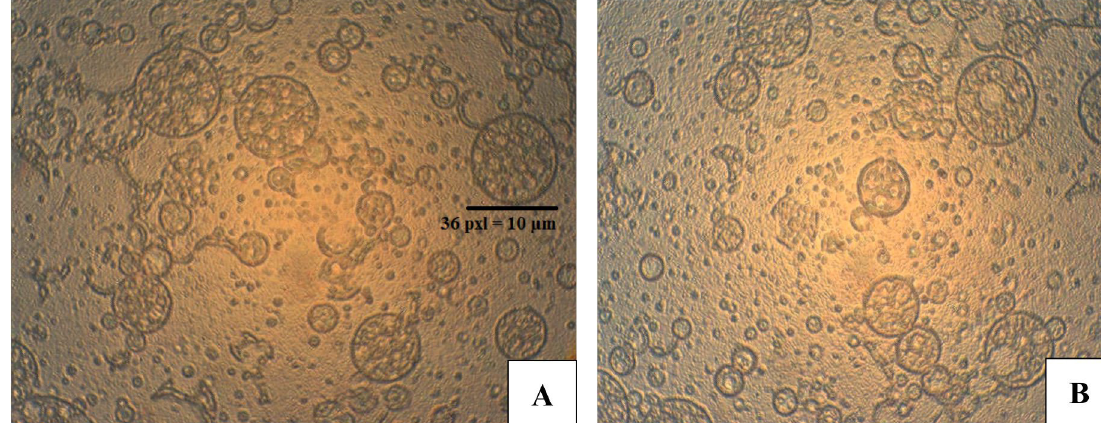
FIGURE 1 - Photomicrographs of multiple emulsions. A = Fresh sample MeA, B = Fresh sample